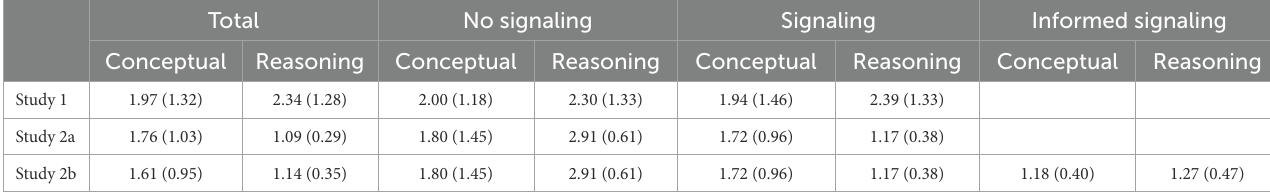
Total No signaling